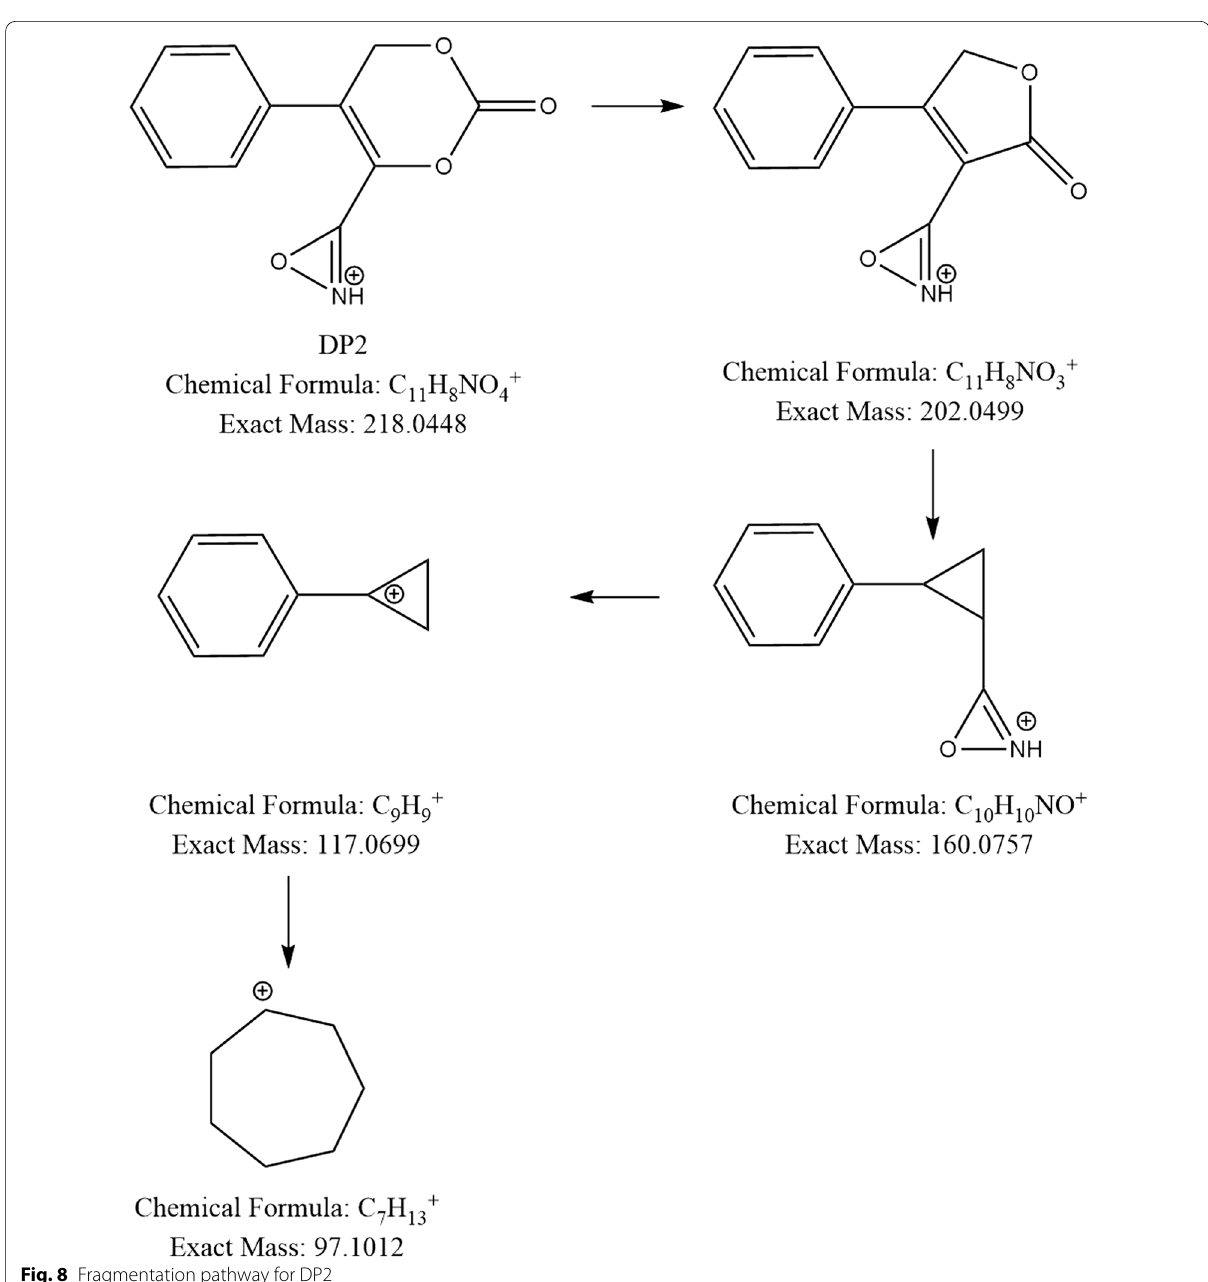
Fig. 8 Fragmentation pathway for